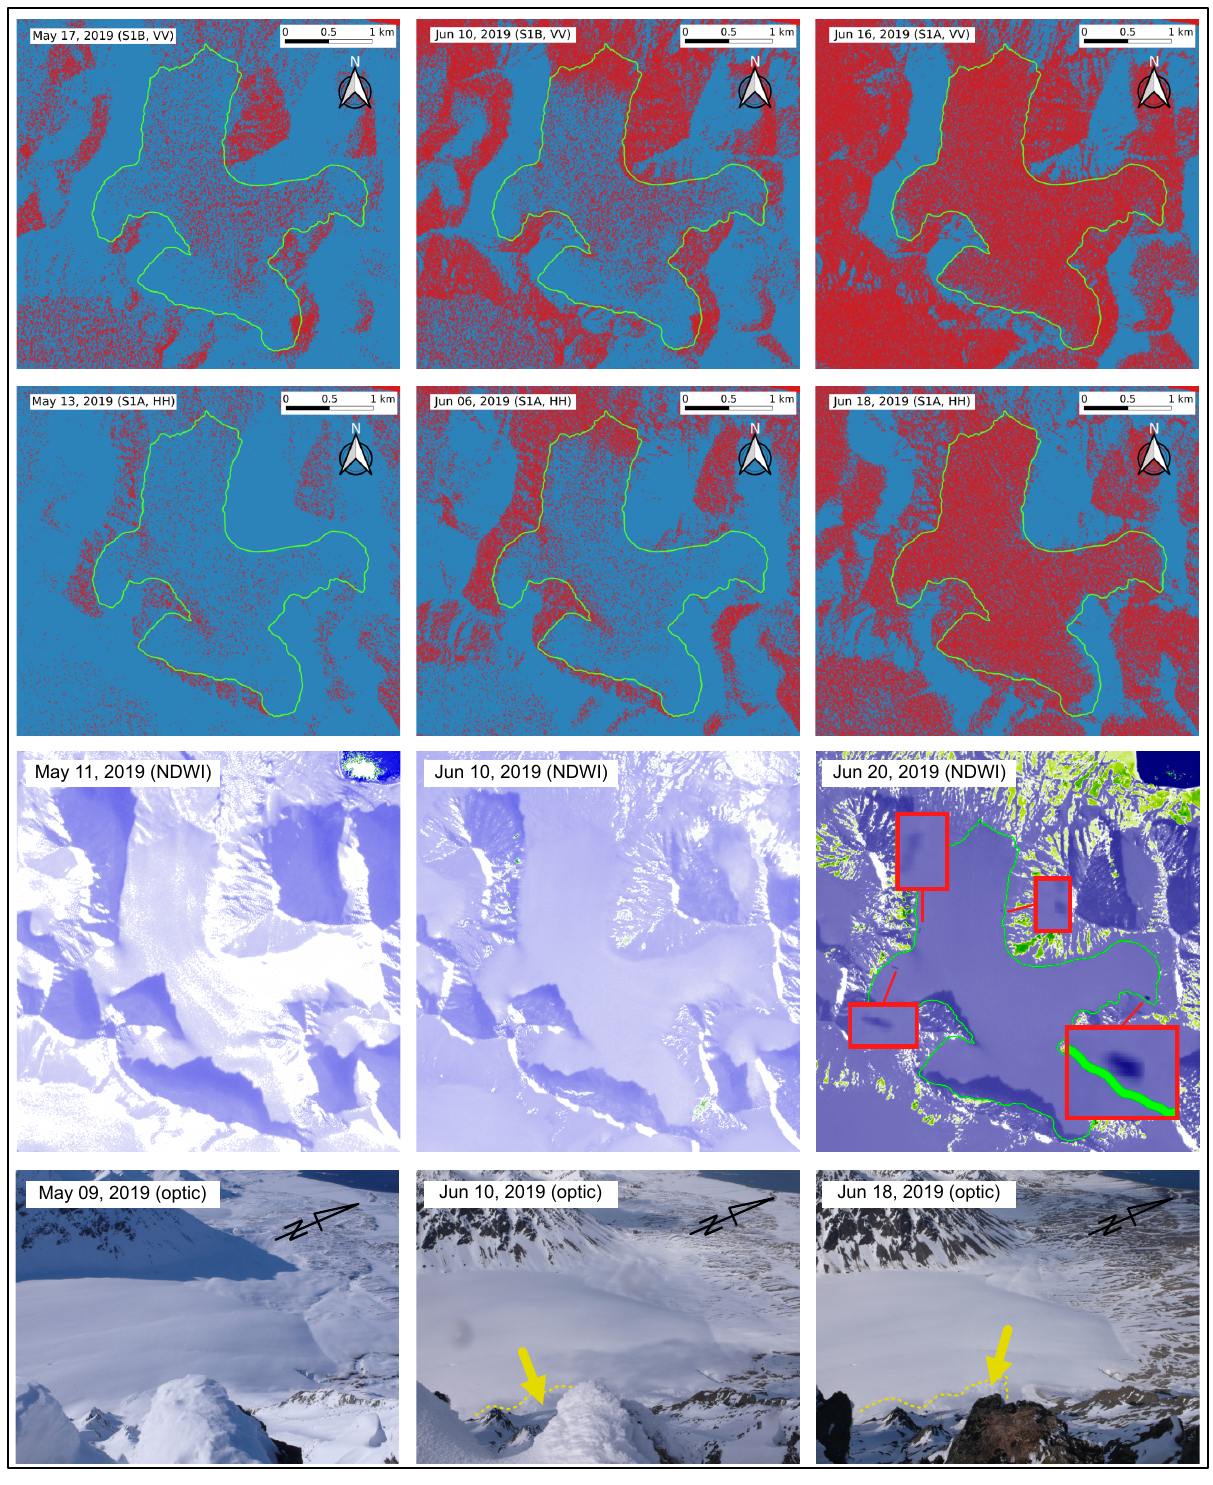
Figure 8. Comparison of the Sentinel-1 microwave reflectivity maps ( top two rows , VV and HH polarizations) with Sentinel-2 multispectral imaging ( second row from bottom ), and ground-based cameras ( bottom ). The magnified areas on the right-most Sentinel-2 image highlight some dark (wet) features visible at the beginning of the melt season as described in the